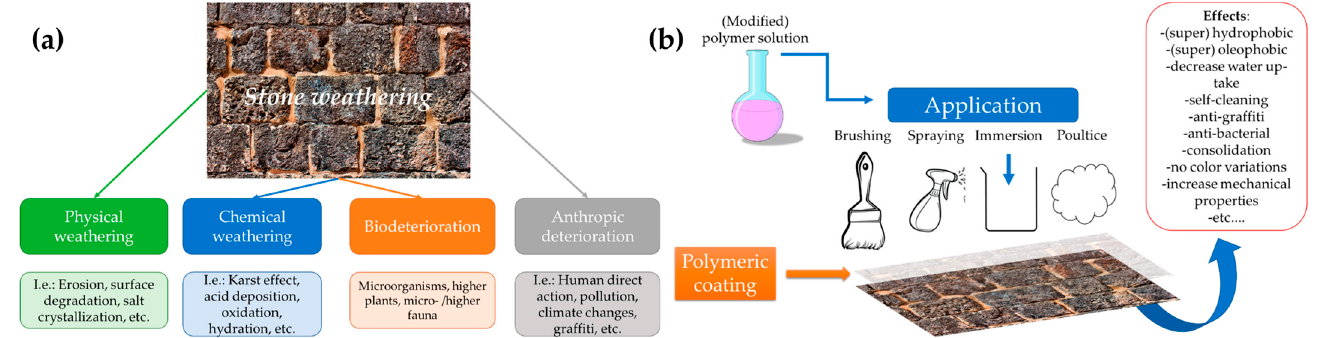
Figure 10. Stone weathering phenomena ( a ) and protective features and implemented properties introduced by the employing of functional polymeric formulations as coatings ( b ). Reproduced from MDPI Ref. [127].